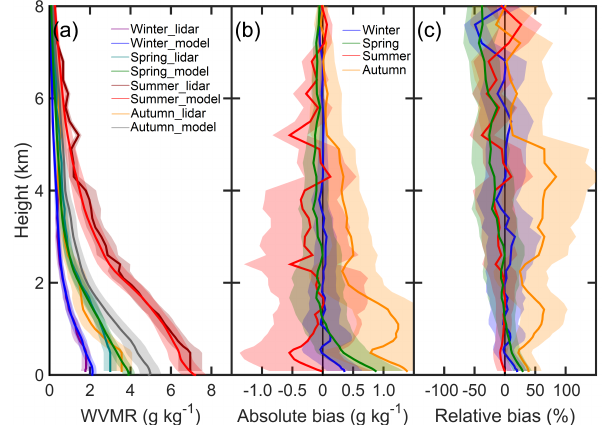
Figure 6. (a) Seasonal water vapor mixing ratios retrieved by the Raman lidar and the model between November 2012 and Au- gust 2016. (b) Respective seasonal absolute and (c) relative biases. Colored lines show the mean profile and shaded areas the